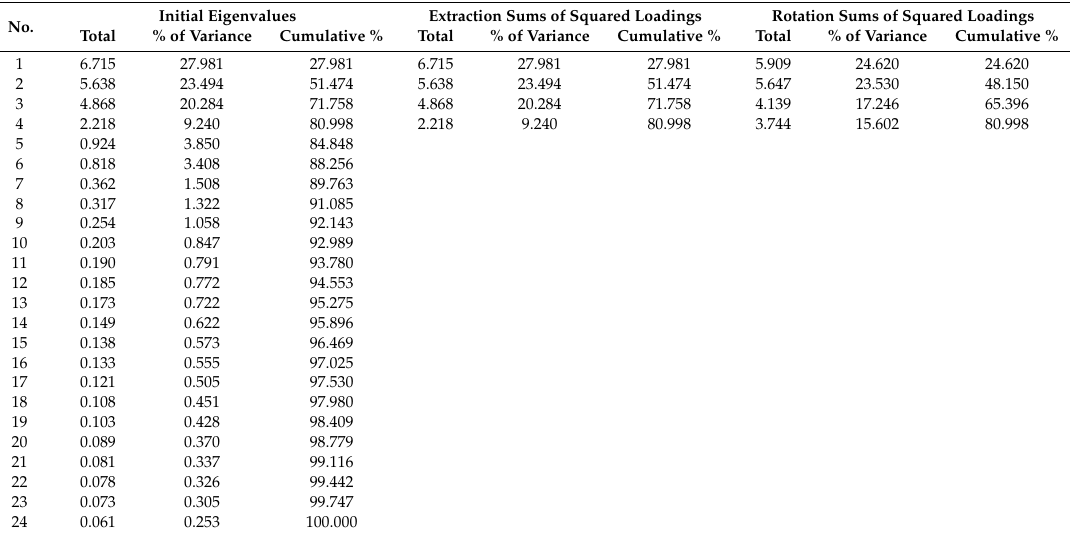
Table 5. Explanation of total